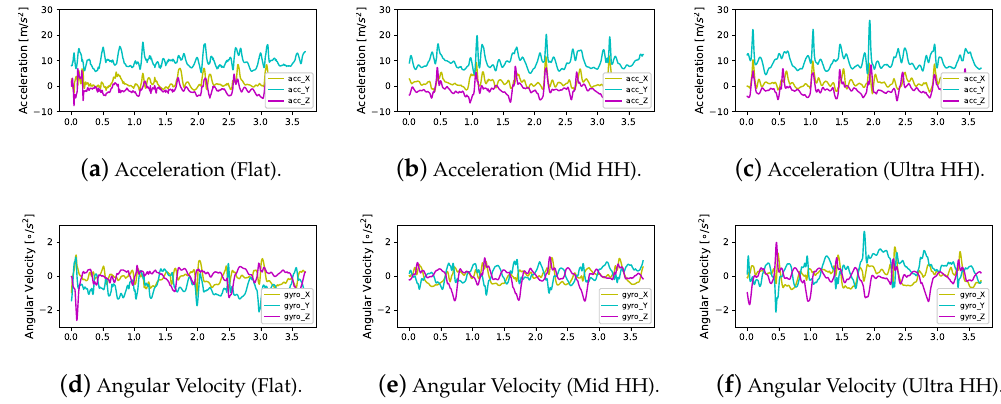
Figure 2. Some sub-sequences of a participant walking three times wearing different shoes (Flat, Mid high heels (HH) and Ultra